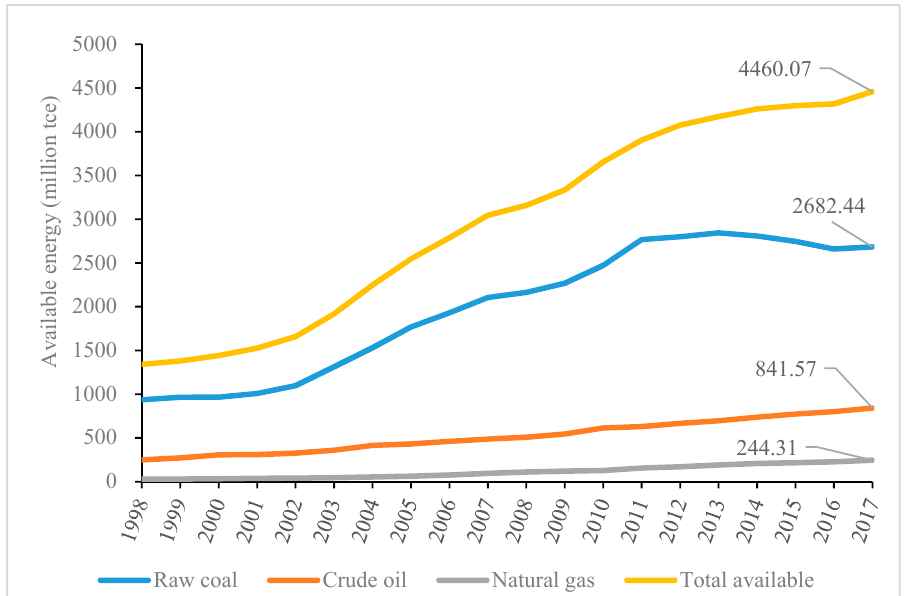
Figure 4. The availabilities of three fossil fuels and their total amount in China from 1998 to 2017 (Data source: China Energy Statistical Yearbook).